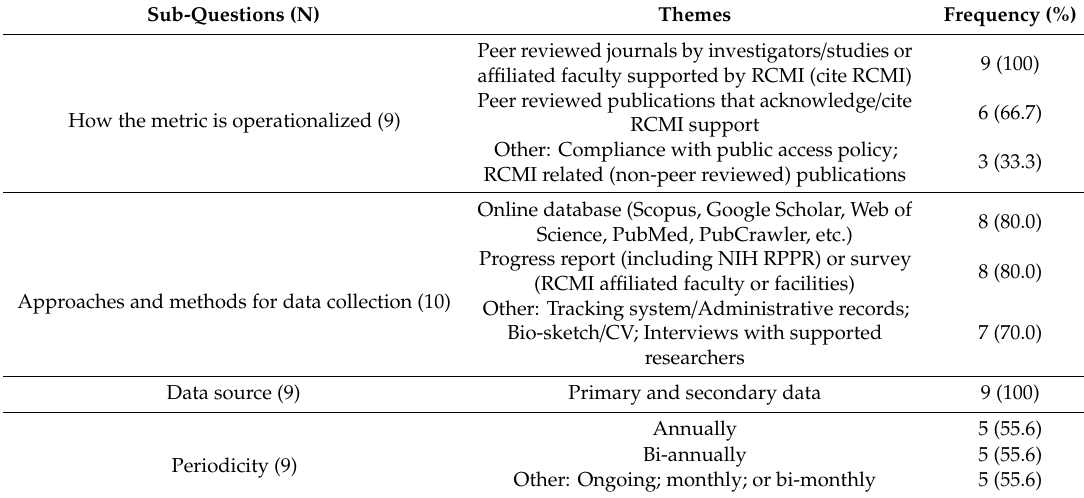
Table 3. Primary target: Increase scientific productivity. Key findings of the case study regarding the operationalization and data collection strategies for the metric “number of peer-reviewed publications”.